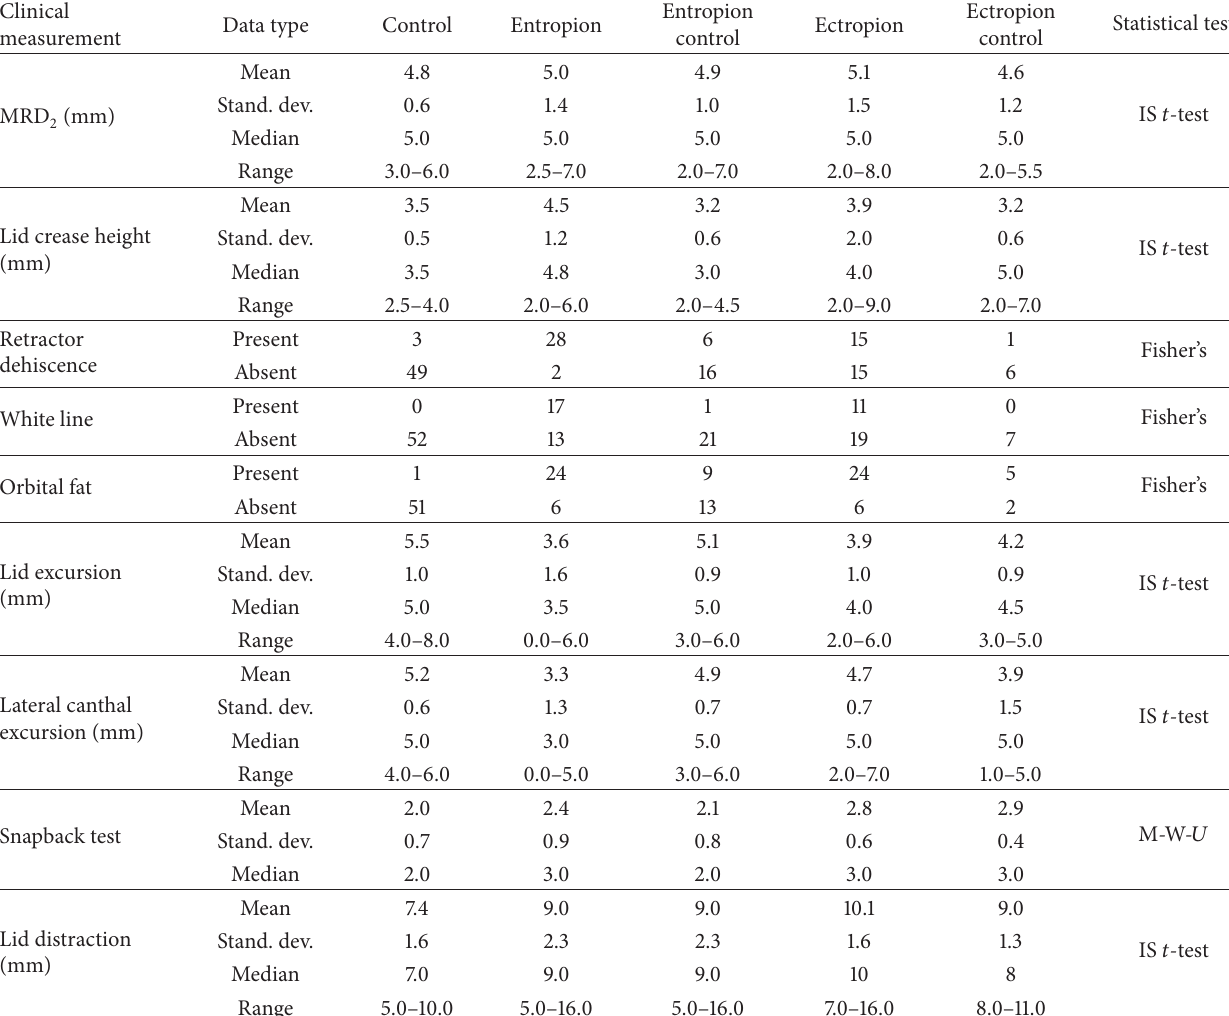
Table 2: Descriptive statistics for each clinical